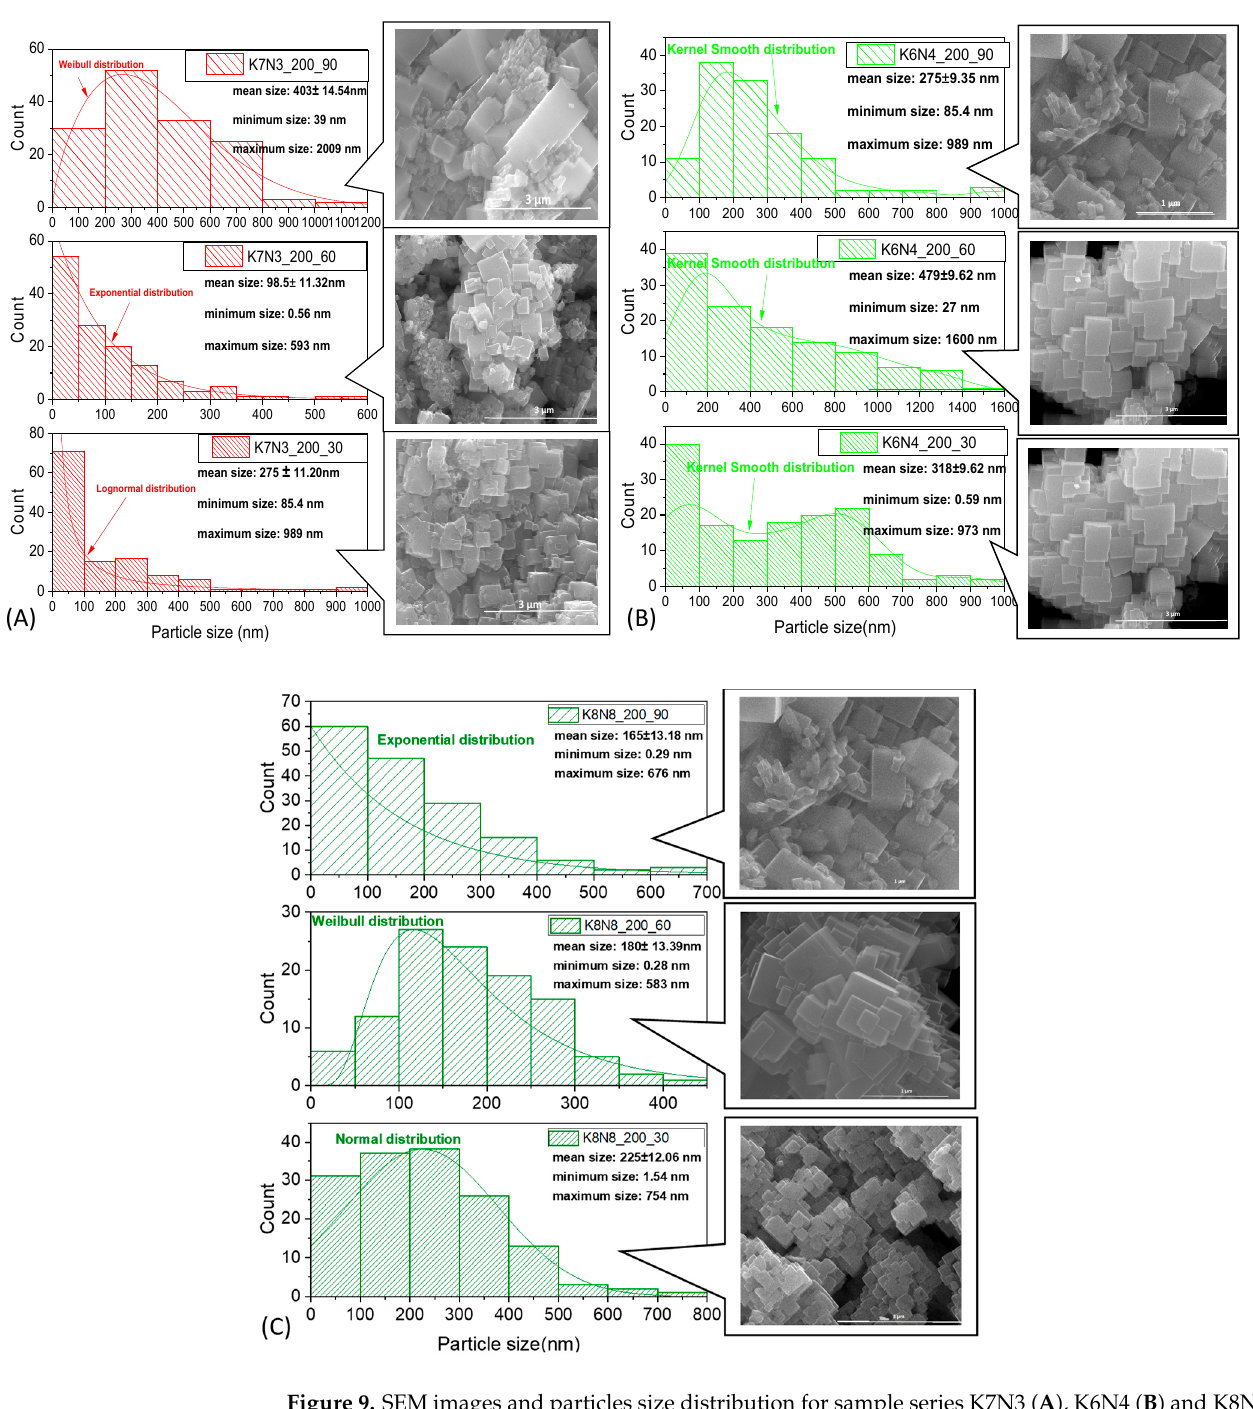
Figure 9. SEM images and particles size distribution for sample series K7N3 ( A ), K6N4 ( B ) and K8N8 ( C ), after 30–90 min of HTMW at 200 °C.